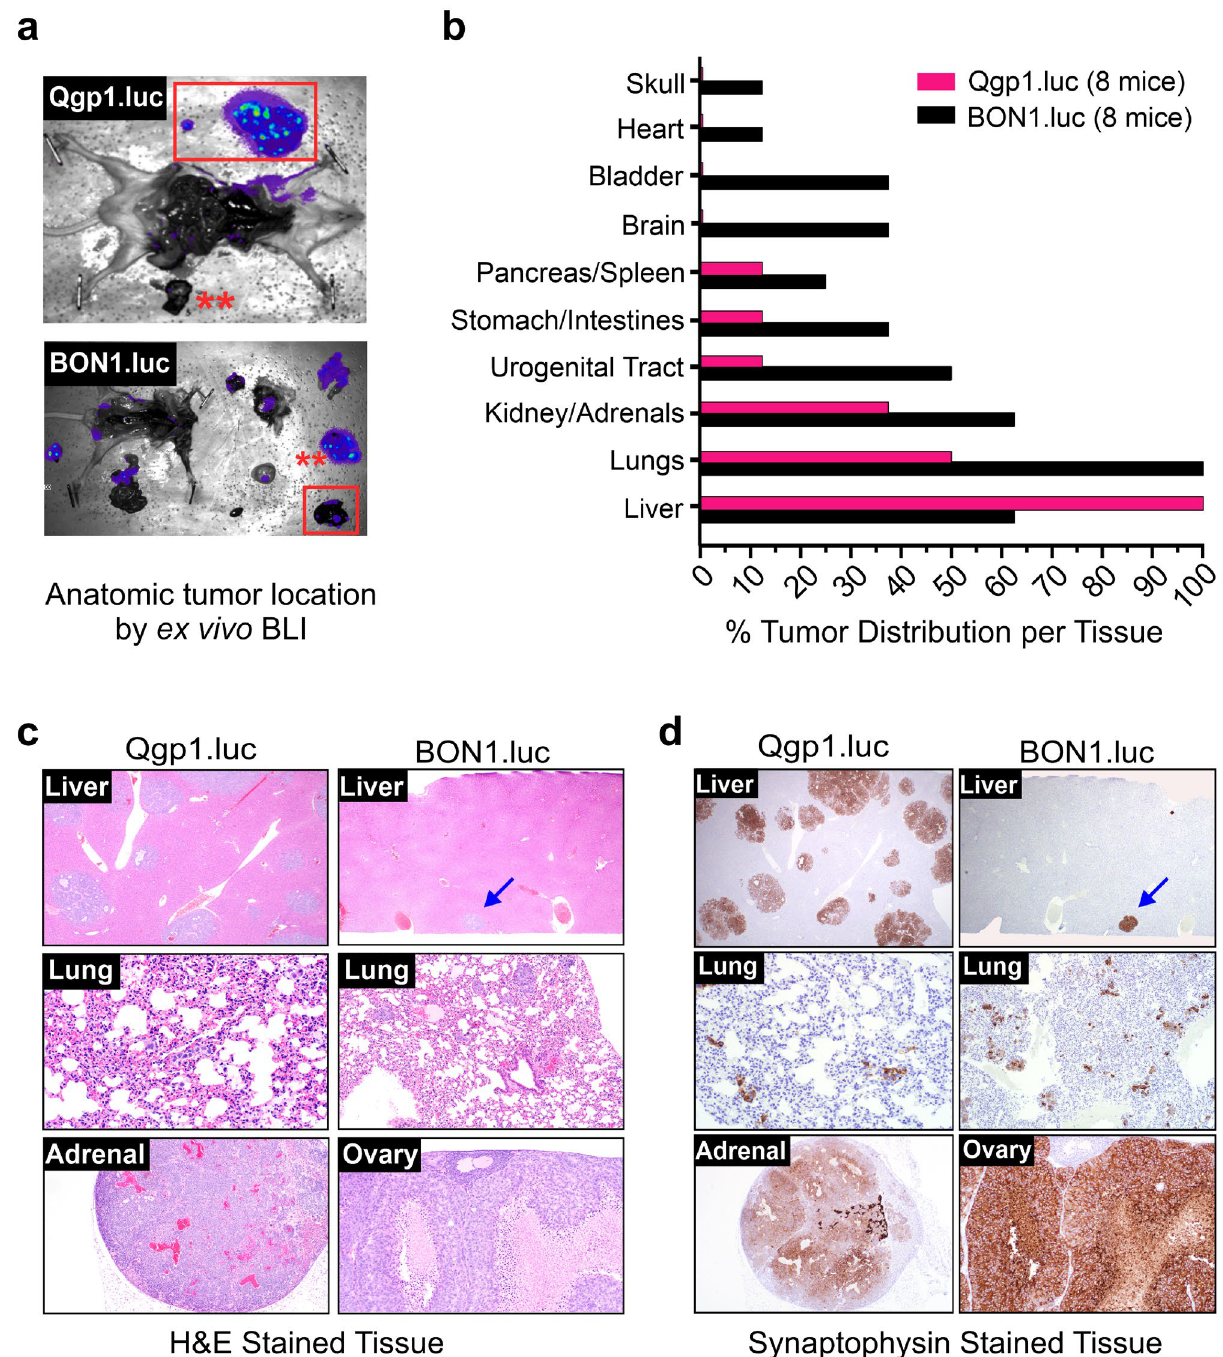
Figure 3. Sites and frequency of tumor distribution in the IC model. ( a ) Ex vivo bioluminescent images (BLI) of tissues to pinpoint the different organ sites of tumor cell colonization. Red boxes, liver; red asterisks, lung. ( b ) Quantified distribution of bioluminescent pNEN cells per tissue. All BON1.luc-injected mice exhibited lung tumors while all Qgp1.luc-injected mice exhibited liver tumors. ( c ) H&E images of Qgp1.luc and BON1. luc tumors in the liver, lung, adrenal and ovary tissues, as indicated in the inset of each image. Tumor cells are stained purple with discrete lesions (upper panels), scattered individual cells throughout the tissue (middle panels), or large lesions overtaking the normal tissue (bottom panels) shown. Blue arrow (top right panel) identifies a single, small BON1.luc liver tumor. ( d ) IHC staining (brown) for the NEN marker, synaptophysin, on the same tissues shown in